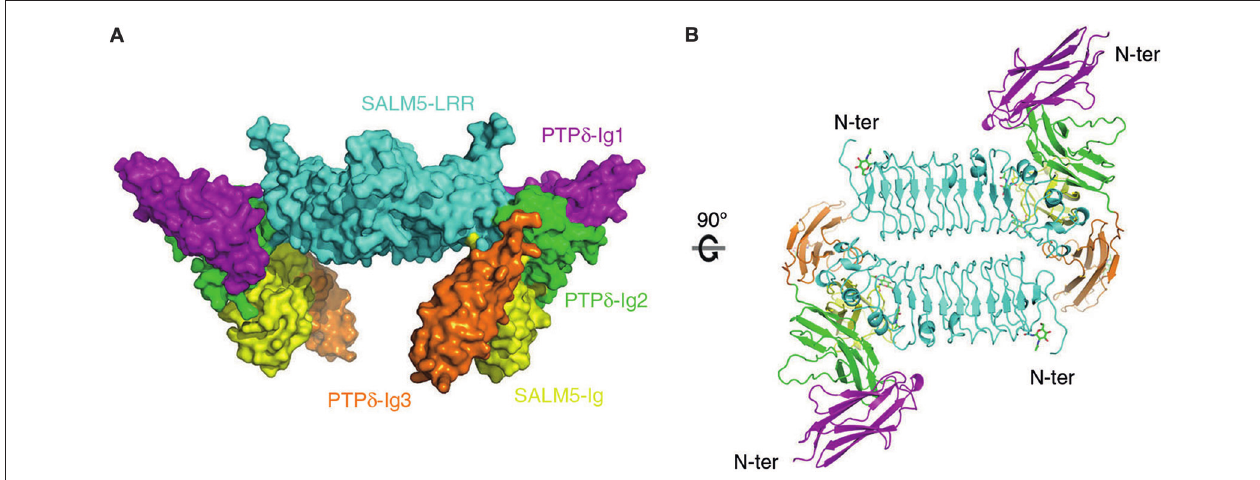
FIGURE 3 | X-ray crystal structure of SALM5 in complex with PTP δ in a 2:2 heterotetrameric format. (A) Side view of the structure (surface representation). (B) Top-down view of the structure (ribbon diagram). These images were borrowed without modification from Figures 1B,C of a recent report on the crystal structure of SALM5 in complex with PTP δ (Lin et al., 2018), which are under a Creative Commons Attribution 4.0 International License